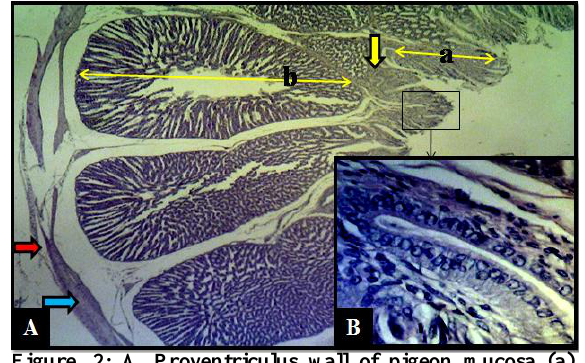
Figure, 2: A. Proventriculus wall of pigeon mucosa (a), submucosa (b), muscularis (blue arrow), serosa (red arrow) and muscularis mucosa (yellow arrow), (H and E, X100) B. epithelial cells in mucosa, (H and E,